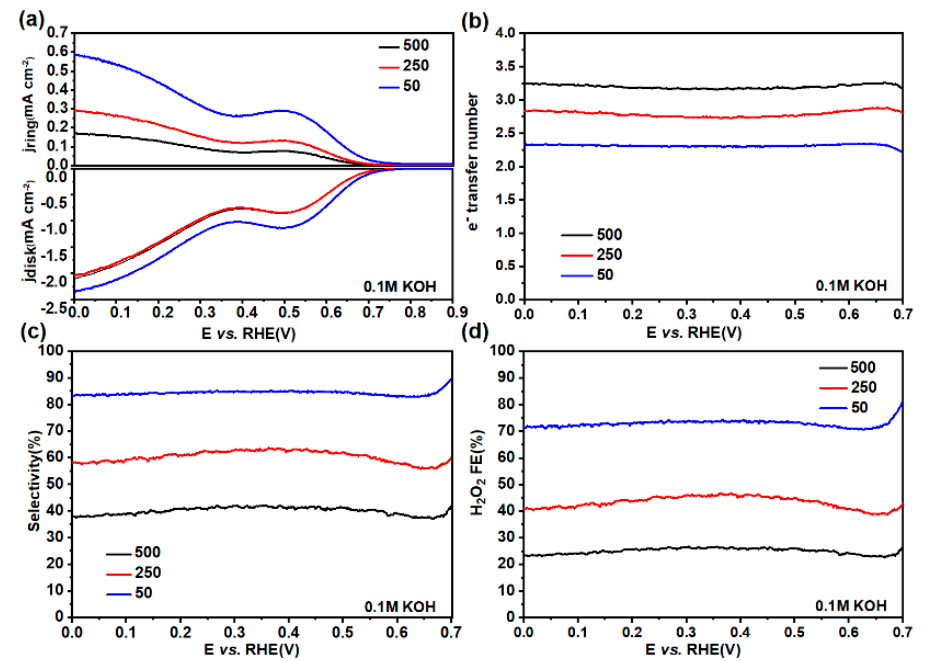
Figure 6. ( a ) Different loadings of O-Mo 2 TiC 2 : LSV curves in 0.1 M KOH solution at 1600 rpm. ( b − d ) Transfer electron number, H 2 O 2 selectivity, and Faradaic efficiency of O-Mo 2 TiC 2 with different loadings in 0.1 M KOH solution.